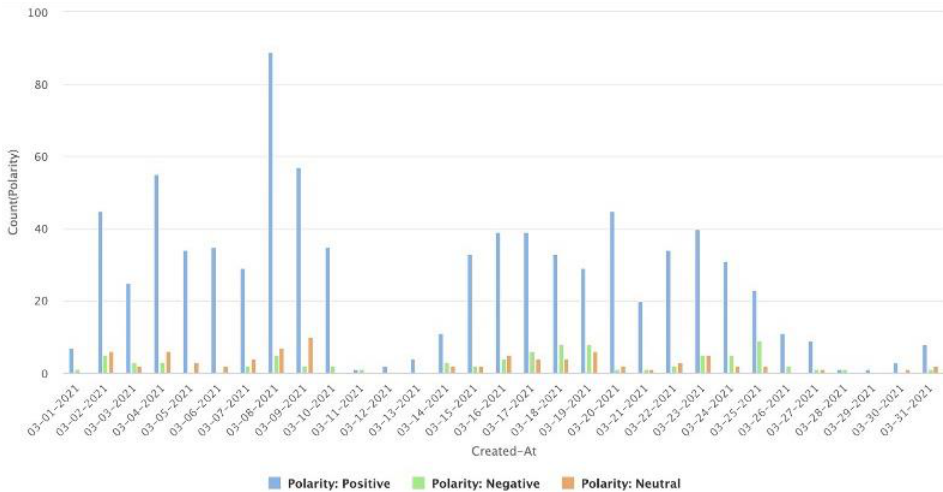
Figure 8. Processed dataset through time aggregated by the polarity of tweets. The chart shows tweets per day and their polarity classified as positive, negative, and neutral.